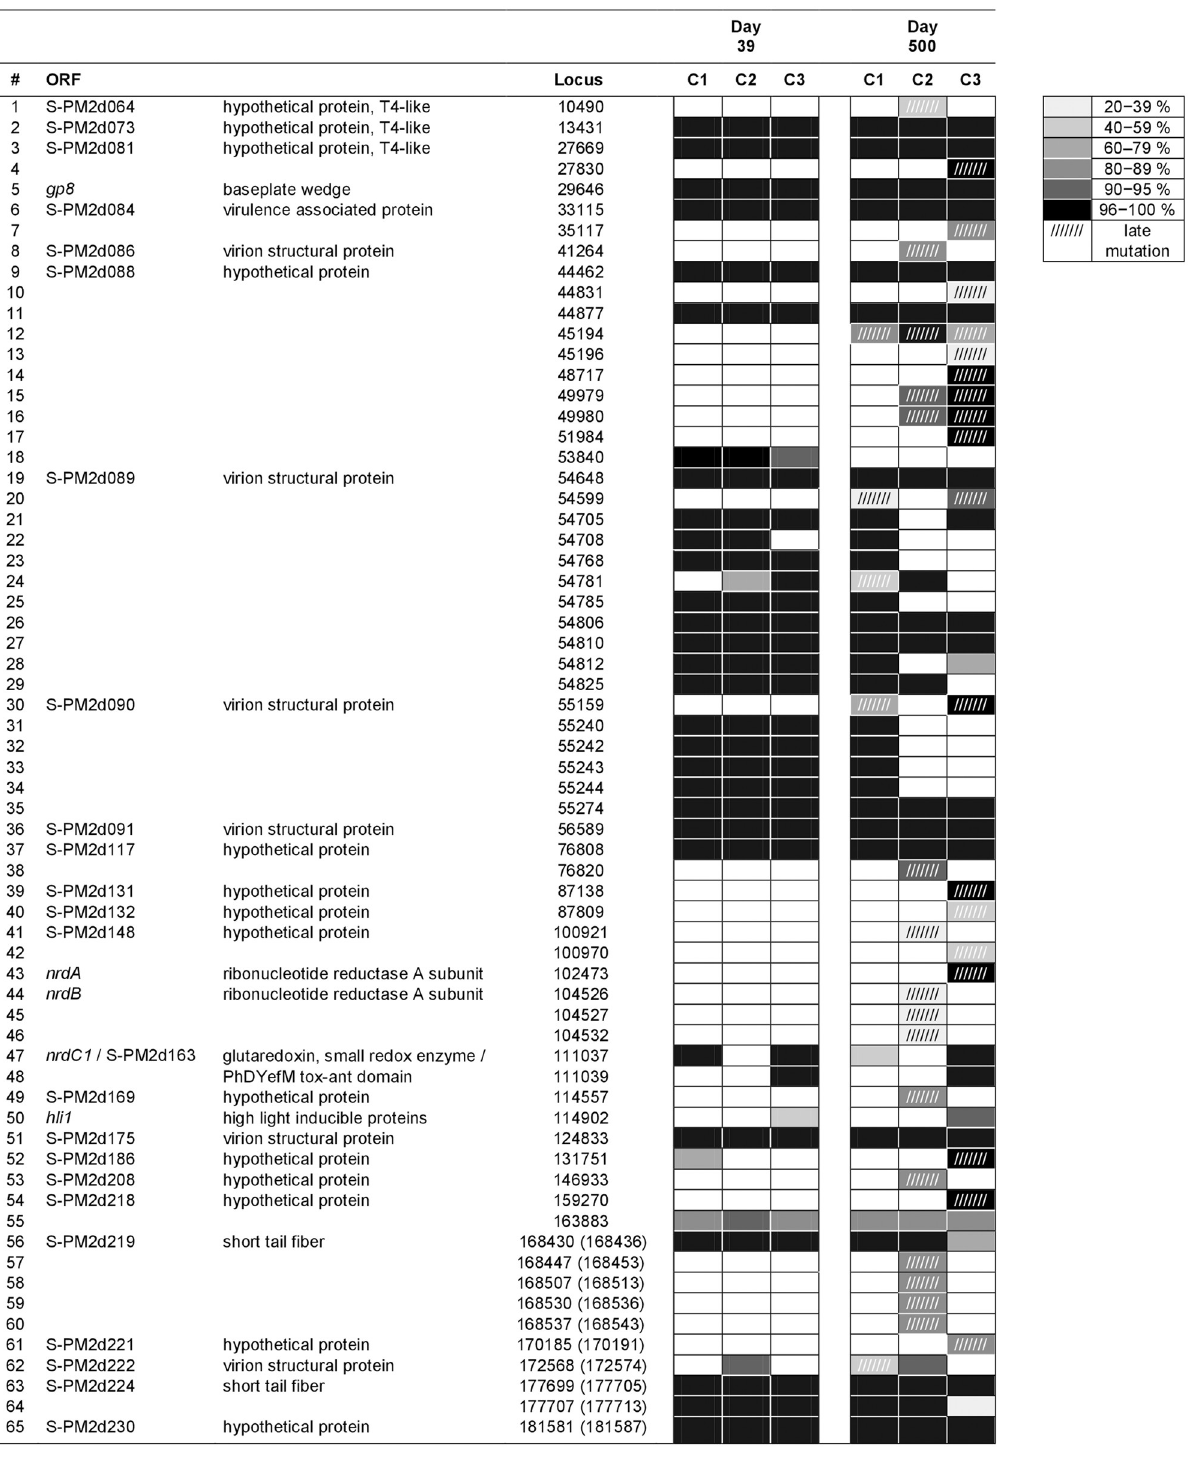
Fig 2. Overview of the genomic changes to the cyanophage S-PM2d populations. The loci and frequencies of mutations detected in the cyanophage S-PM2d populations across three replicate chemostats (C 1–3), 39 and 500 days after infecting the host Synechococcus sp. WH7803. Aside from #2 and #18, all the mutations are non-synonymous. The intensity of the shaded cell indicates the frequency (i.e. % of the corresponding sequencing depth) at which the mutation was found. Unshaded cell = absence of mutation; cell with slashes = late mutation detected only on day 500; ORF = open reading frame. In general, the early mutations (detected on day 39) are present in all three cyanophage populations and at very high frequencies, whereas the late mutations (detected on day 500) are less repeatable across the populations and are found at a larger range of frequencies. https://doi.org/10.1371/journal.pone.0281537.g002 PLOS ONE | https://doi.org/10.1371/journal.pone.0281537 February 9,